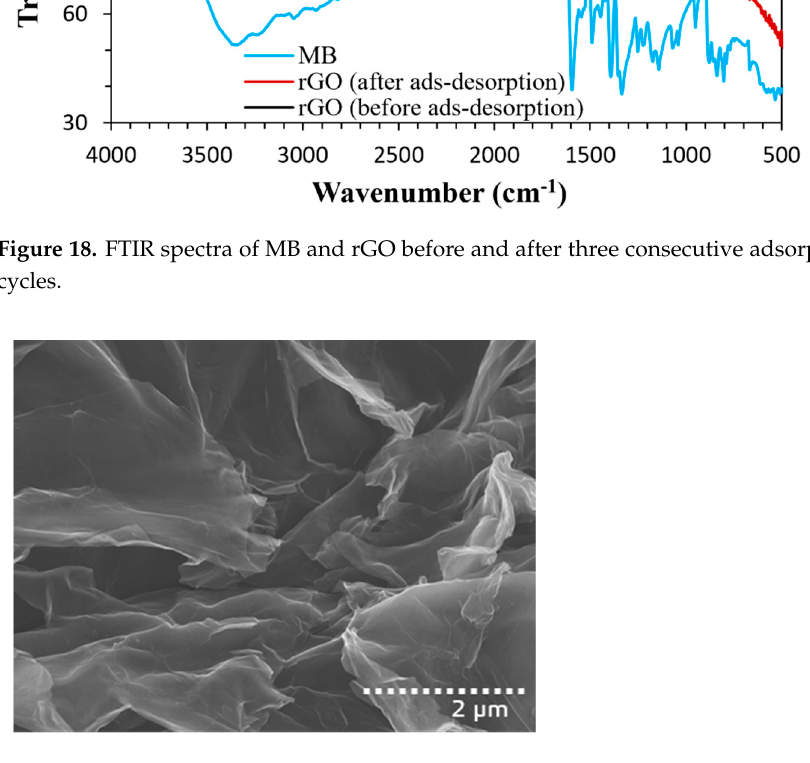
Figure 19. SEM images of rGO used for three consecutive adsorption-desorption cycles.